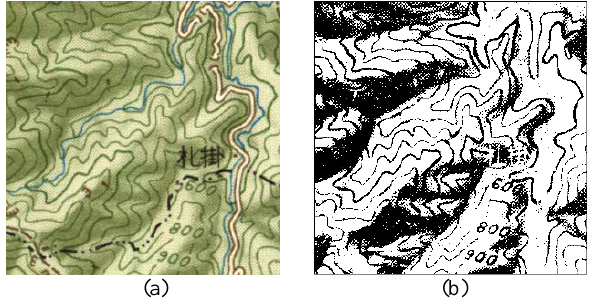
Figure 1. A part of a colour topographic map with relief shadings. a Original image. b The colour segmentation result of contour line layer